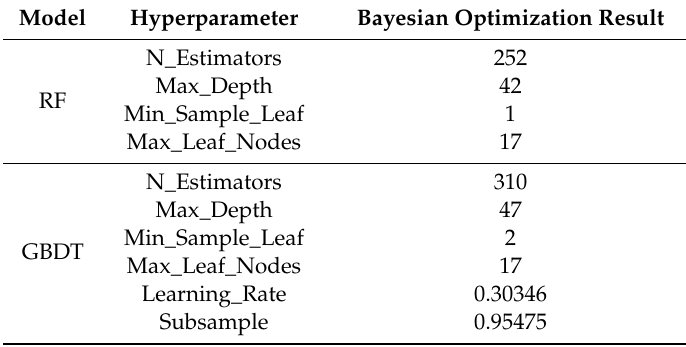
Table 3. The Bayesian Optimization Result of hyperparameters in the RF and GBDT models.